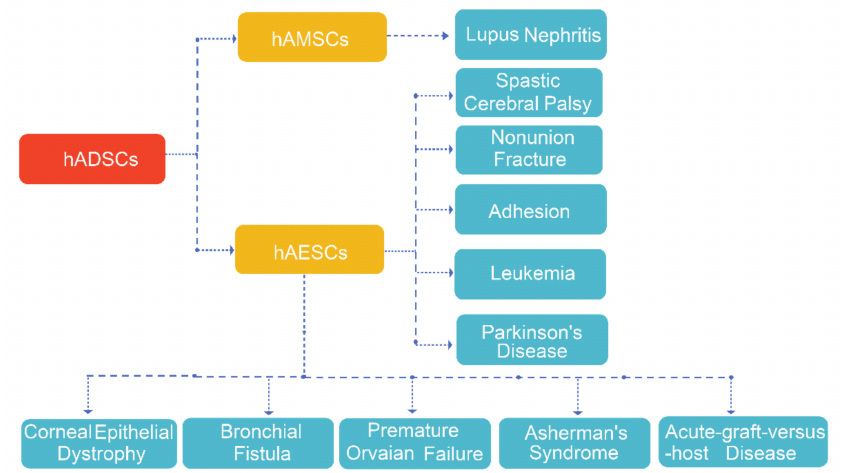
Figure 4. Clinical application of